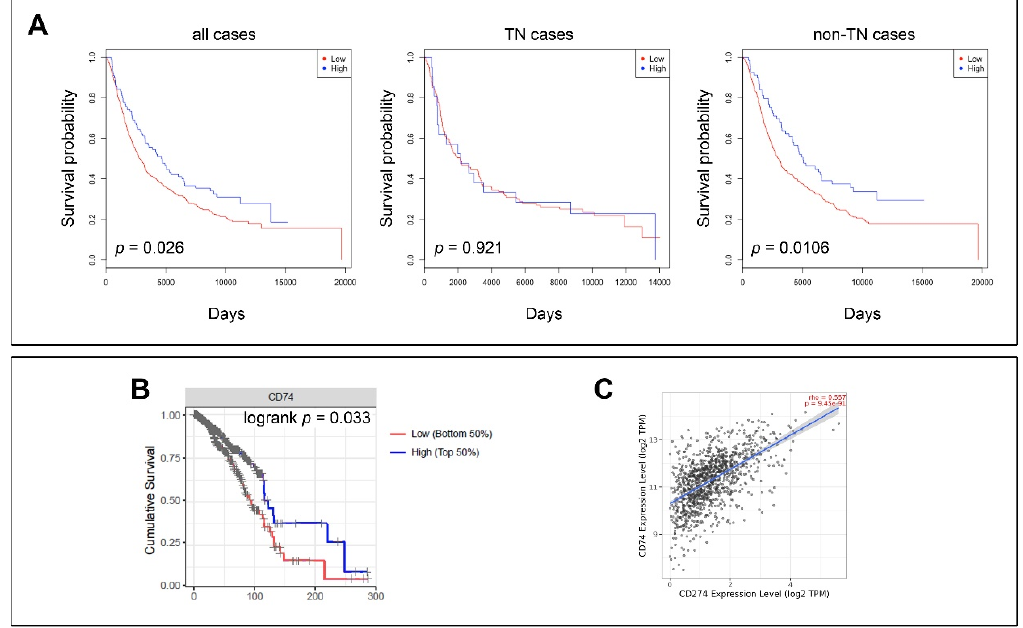
Figure 4. Survival analysis of breast cancer samples as a function of CD74 expression. ( A ) The prognostic value of CD74 expression was examined in the YTMA49 cohort for all cases, TN cases, and non-TN cases. ( B ) Kaplan–Meier plot showing OS among breast cancer patients according to CD74 expression in a multivariate model correcting for immune cell infiltration in a multivariable Cox proportional hazard model. Correlation between CD74 gene expression and infiltration of immune cells was examined in the breast cancer samples available from TCGA database with the TIMER analysis tool (http://timer.cistrome.org) (accessed on 8 March 2019) ( C ) Correlation between CD74 and PD-L1 in 1017 breast carcinomas from TCGA after correcting for tumor-infiltrating immune cells.